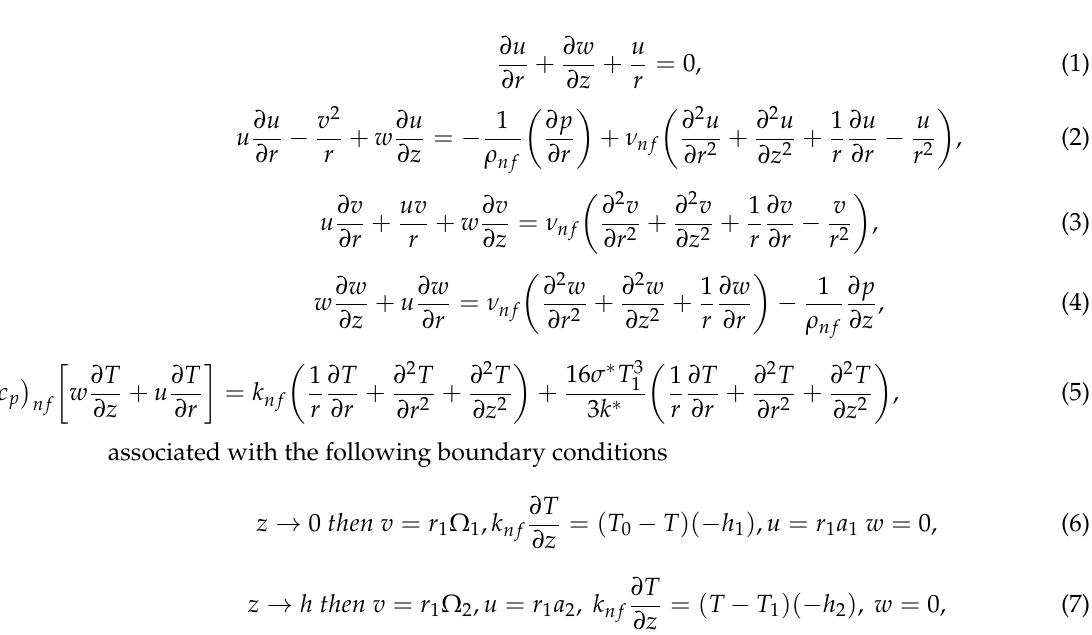
Figure 1. Systematic diagram of the problem [44,45].